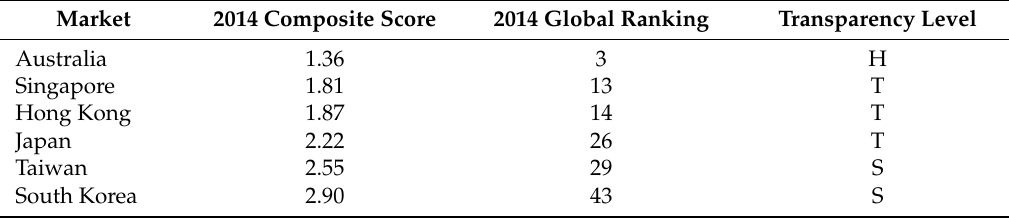
Table 3. Jones Lang LaSalle (JLL) Transparency